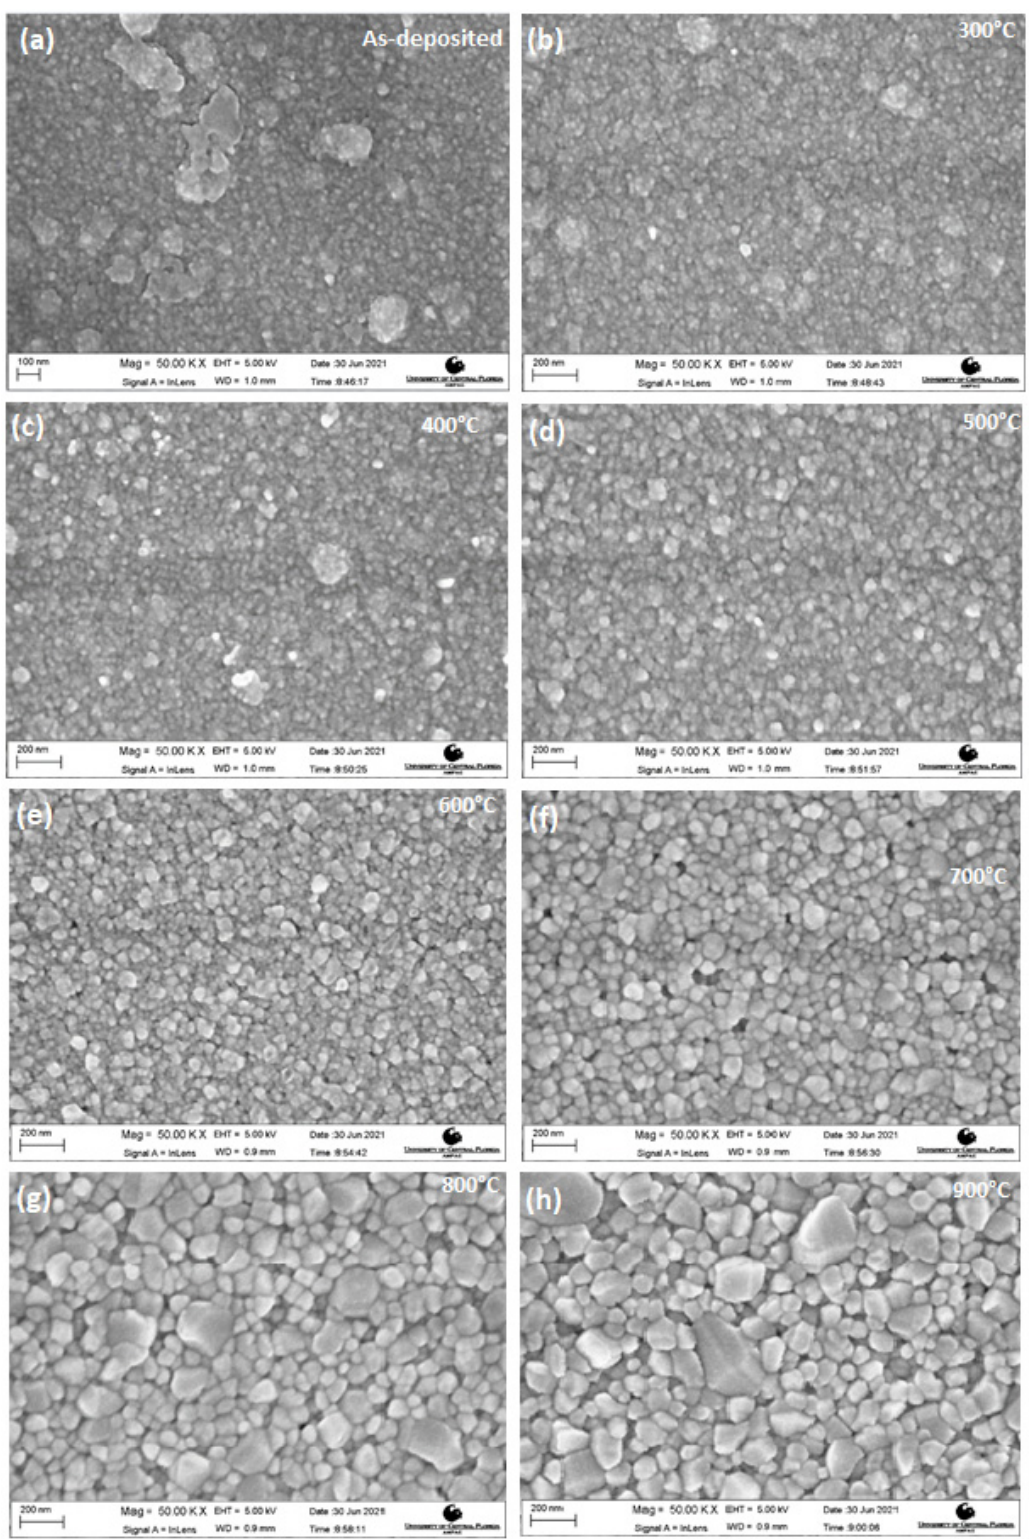
Figure 4. FESEM images of ( a ) the as-deposited CuGa 2 O 4 films and the CuGa 2 O 4 films annealed at ( b ) 300 °C, ( c ) 400 °C, ( d ) 500 °C, ( e ) 600 °C, ( f ) 700 °C, ( g ) 800 °C and ( h ) 900 °C (SEM magnification were constant at 50 KX. All scales in the image are in nm range).